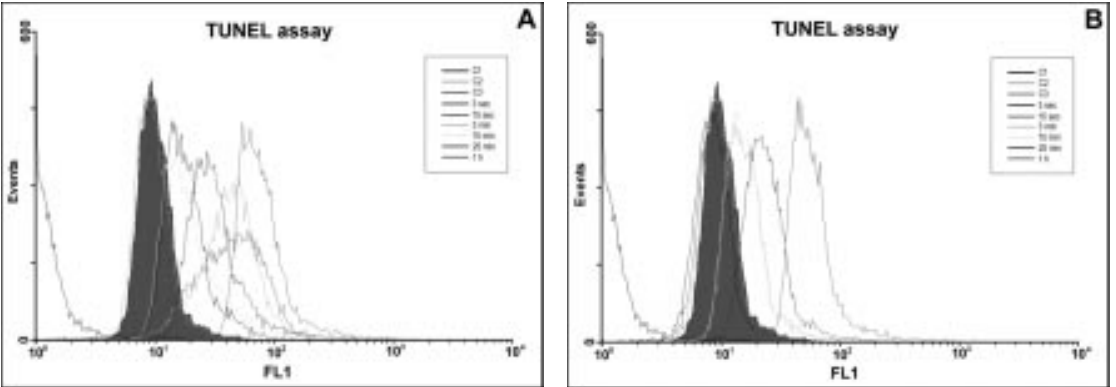
Fig. 7. Fluorescein-12-ddUTP incorporation mediated by exogenous terminal deoxynucleotidyl transferase (TdT) – TUNEL assay, in DNA of HL60 cells. A, cells submitted to a 4-hour period of incubation after irradiation during 3 sec, 30 sec, 3 min, 15 min, 25 min and 1 h. B, cells without the 4-hour incubation period, after irradiation for the same time periods. C1, negative control of autofluorescence; C2, negative control of background/reaction; C3, non-irradiated control cells. Only representative exposure times are shown in the figure, other times referred to in the text have a similar